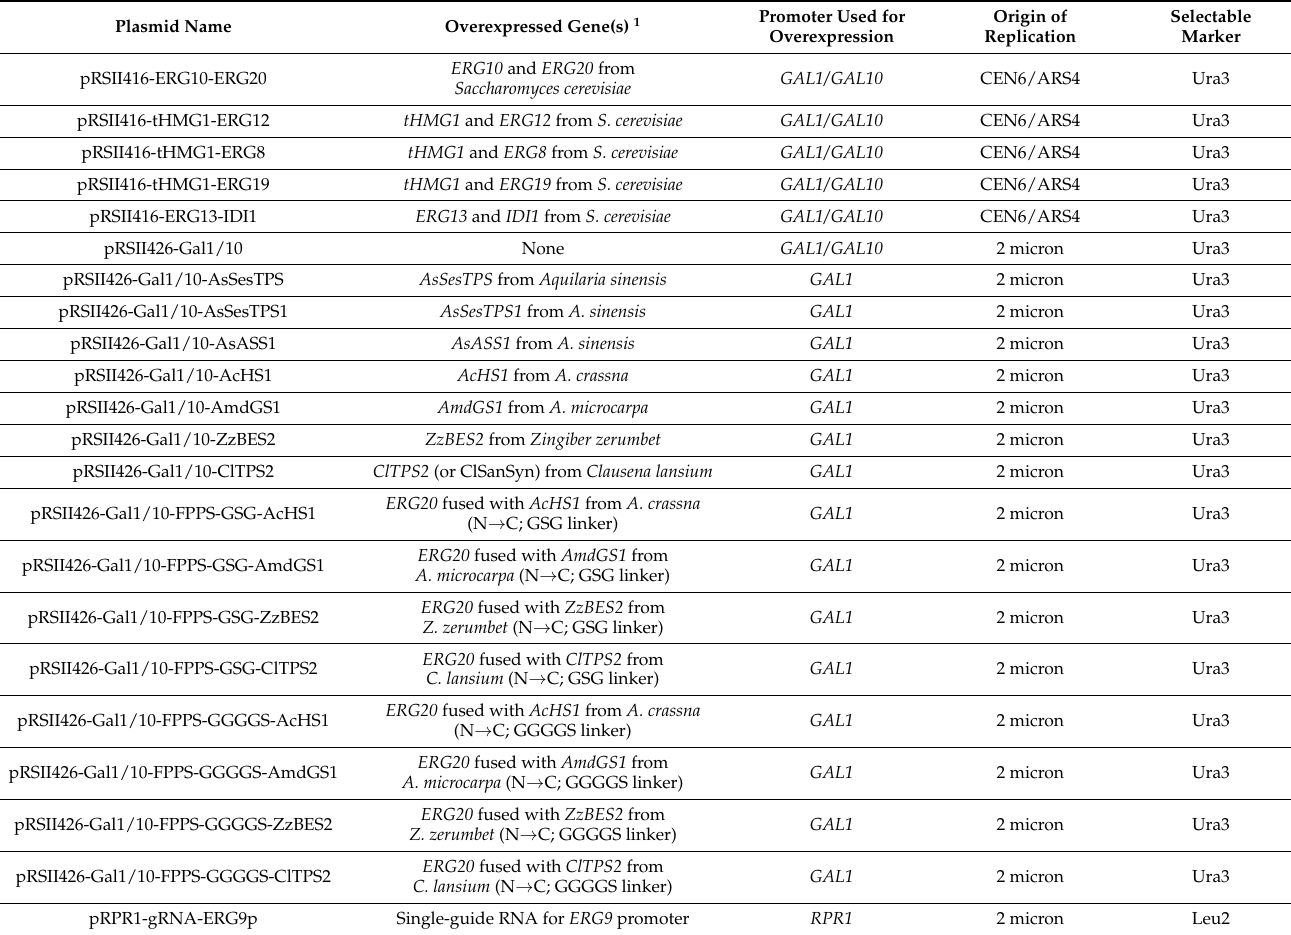
Table 2. Plasmids generated in this